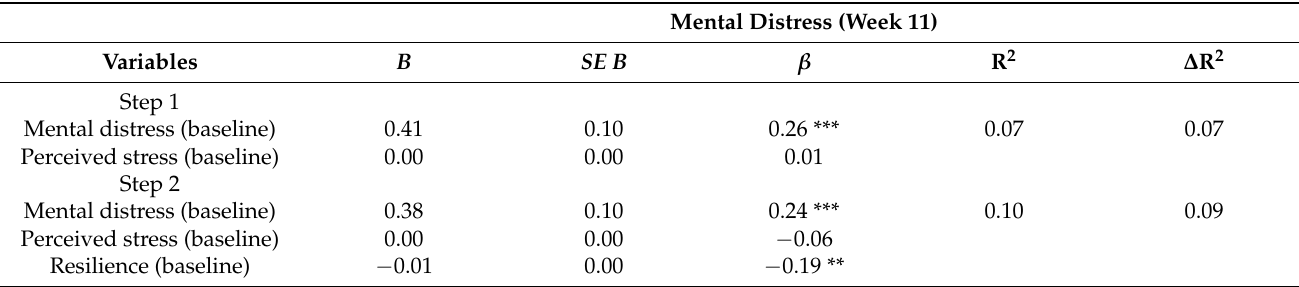
Table 3. The influence of resilience (baseline) on mental distress at week 11 in a hierarchical regression analysis, controlling for baseline values of mental distress GSI and perceived stress.